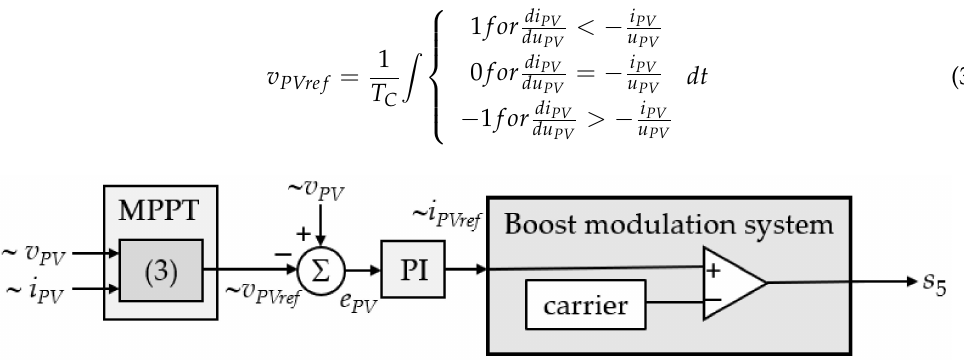
Figure 3. The structure of the DC link voltage control